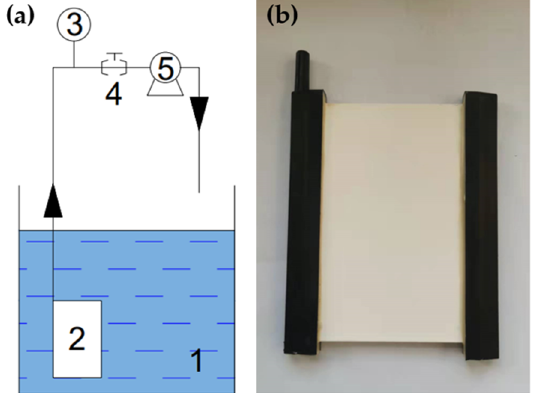
Figure 1. The reactor diagram of filtration apparatus ( a ) 1-feed tank, 2-membrane module ( b ) 3- manometer, 4-regulating valve, 5-pump.